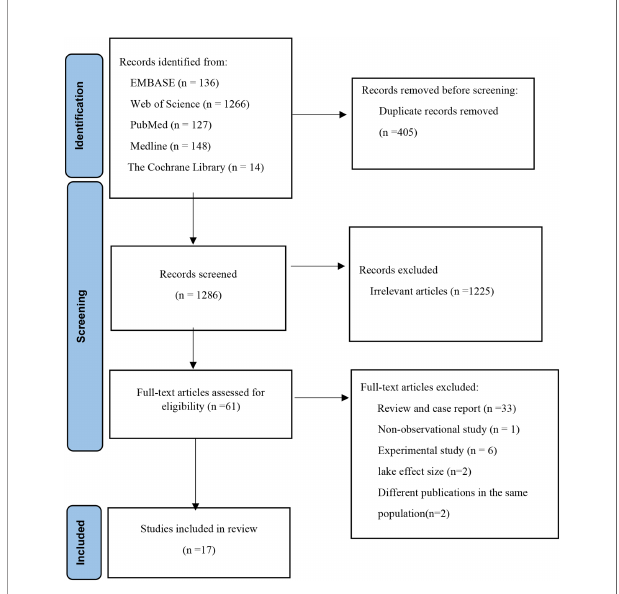
FIGURE 1 | Flow diagram outlining the systematic search and articles selection